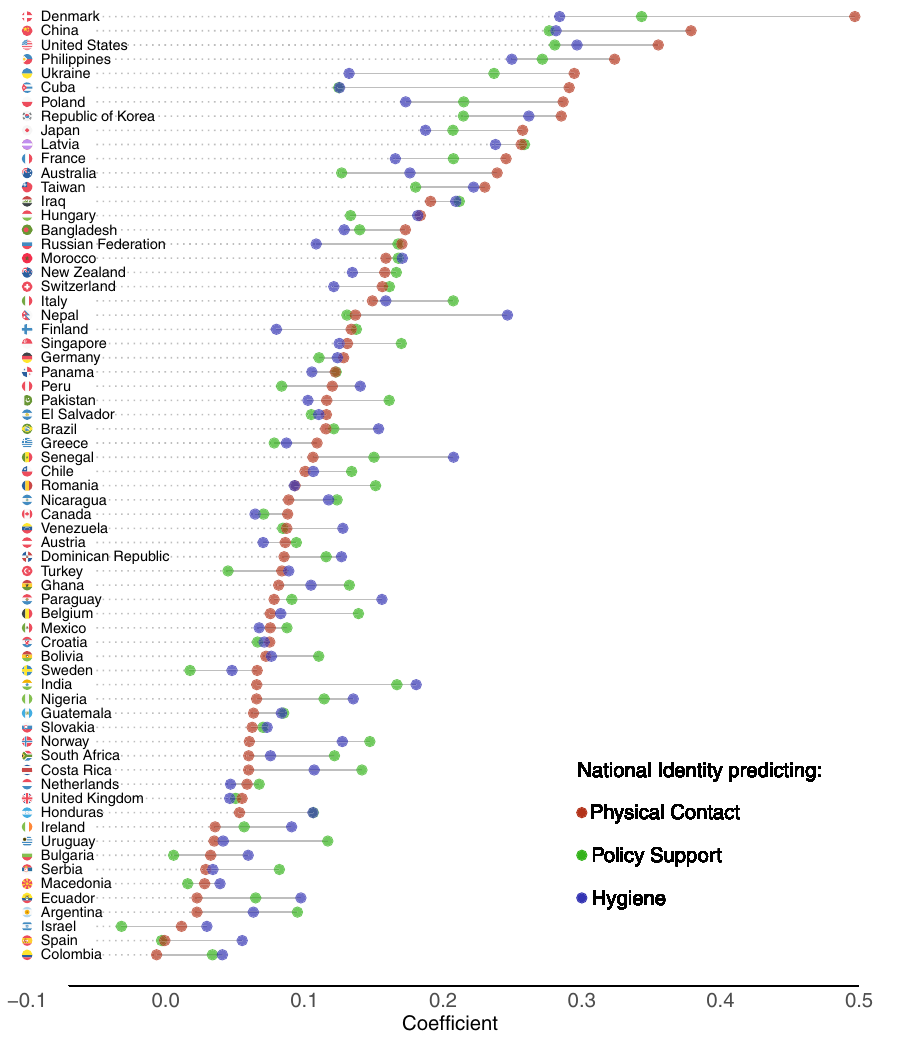
Fig. 3 Relation between collective concerns and public health measures in 67 countries and territories. The coef fi cients re fl ecting the relation between national identity and each of the health measures are presented for each country from strongest (top) to weakest (bottom). The relation with physical contact (red), policy support (green), and hygiene (blue) are colour